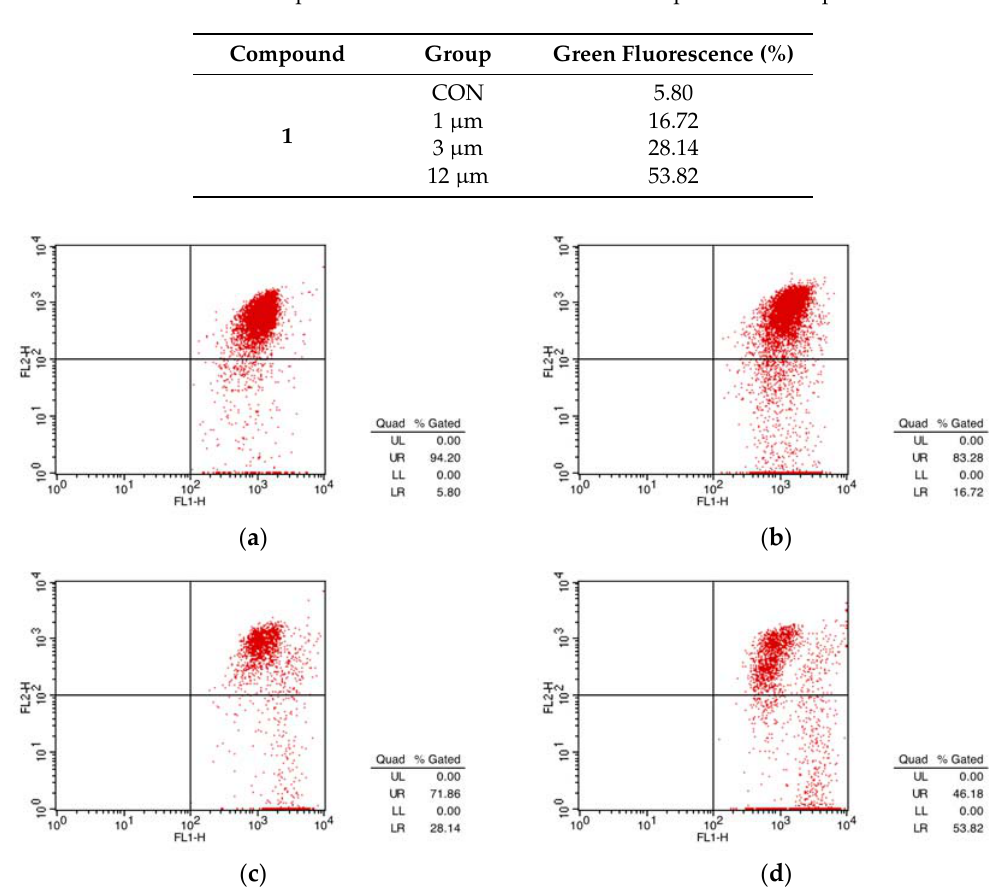
Table 4. Effect of compound 1 on mitochondrial membrane potential in HepG2 Cells.